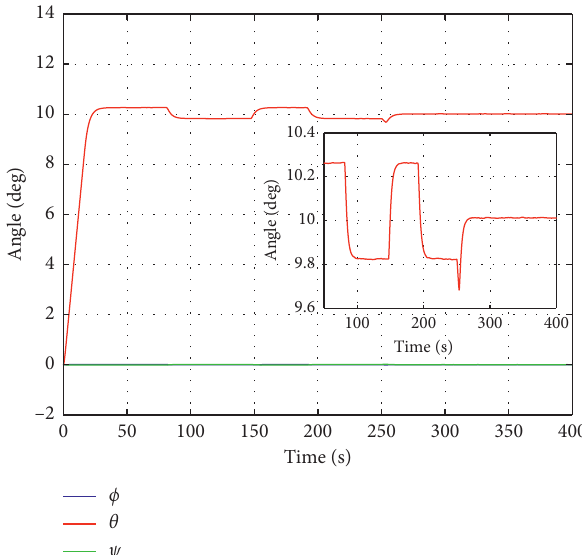
Figure 6: Attitude angle of air-bearing test bed.